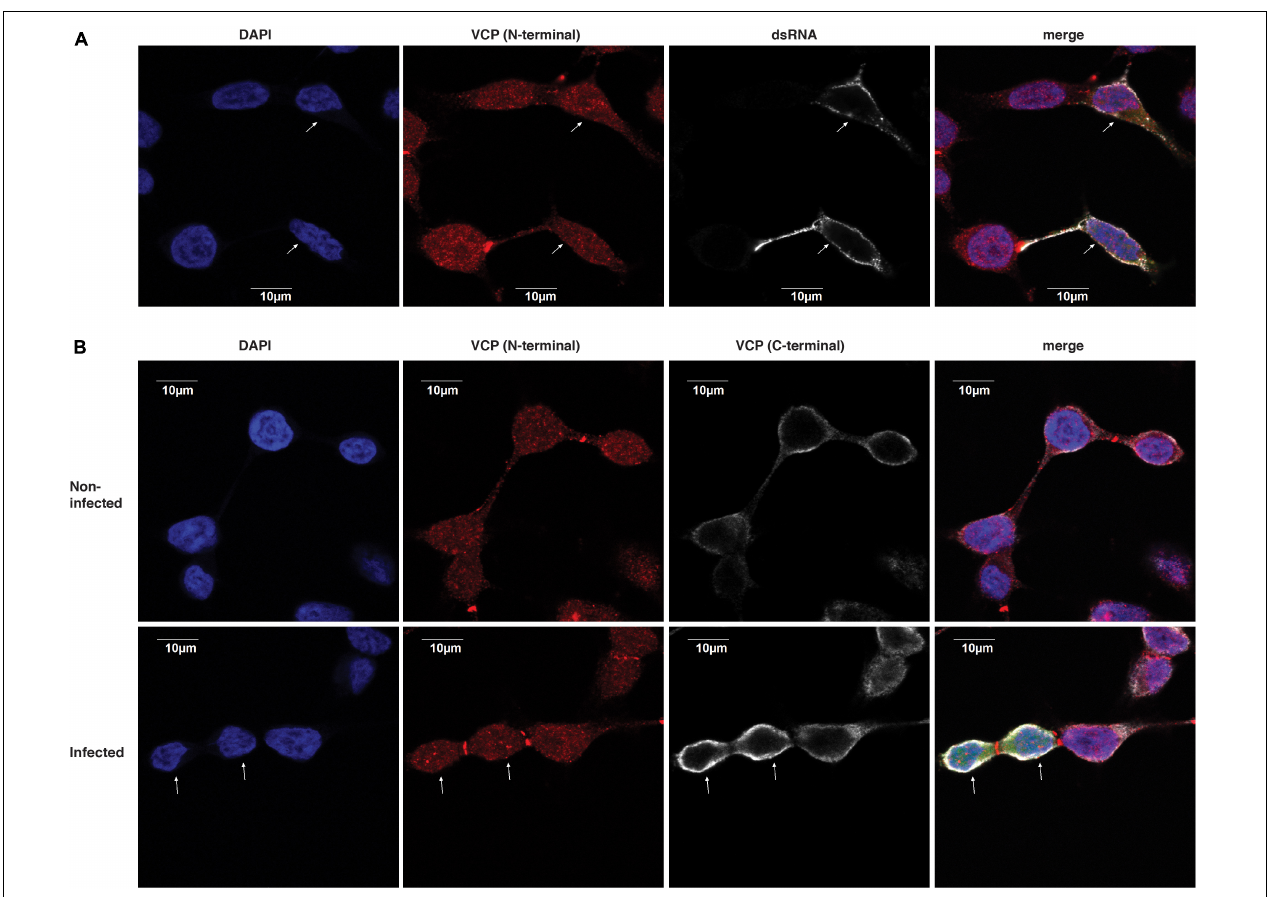
FIGURE 6 | dsRNA foci do not colocalize with VCP. HEK 293T cells were infected at an moi of 10 with ZsGreen-tagged CHIKV-LR, 2 hpi cells were washed and re-plated in Ibidi µ -wells microscopy chambers. At 5 h post-plating, cells were fixed, permeabilized, and co-stained for VCP and dsRNA as indicated on the figure. Cells were counterstained with DAPI before confocal acquisition. (A) Representative focal plane of VCP with dsRNA staining in infected cells. (B) Representative focal plane of VCP (N-terminal) and (C-terminal) staining. Results are representative of two independent experiments performed in triplicates. White arrows indicate infected cells which were determined using the ZsGreen channel (shown only in the merged